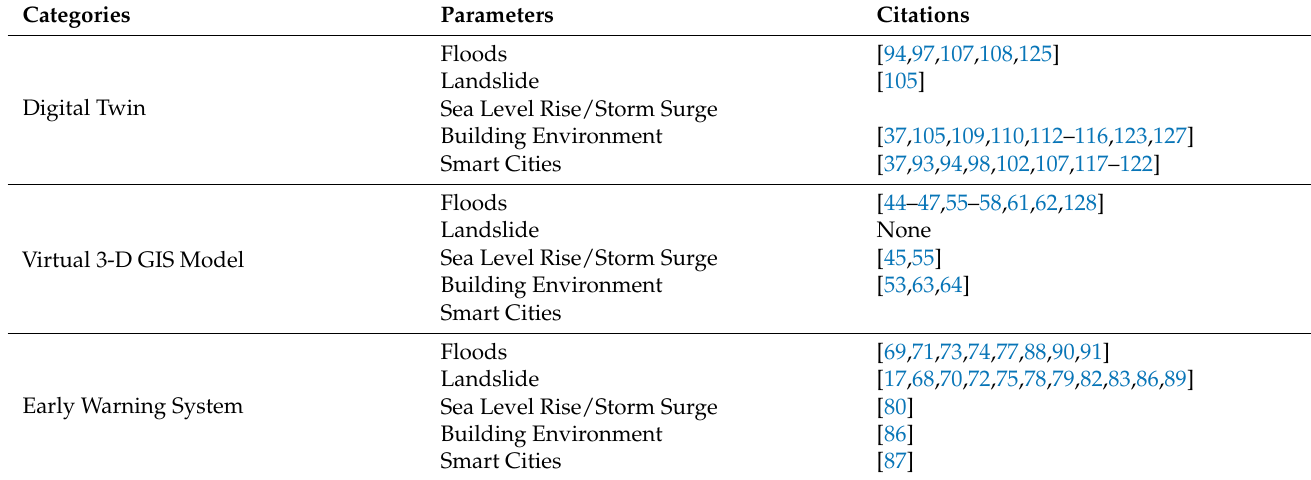
Figure 7. Number of studies reviewed according to different environmental parameters. Table 5. Distribution of reviewed studies based on various environmental parameters.